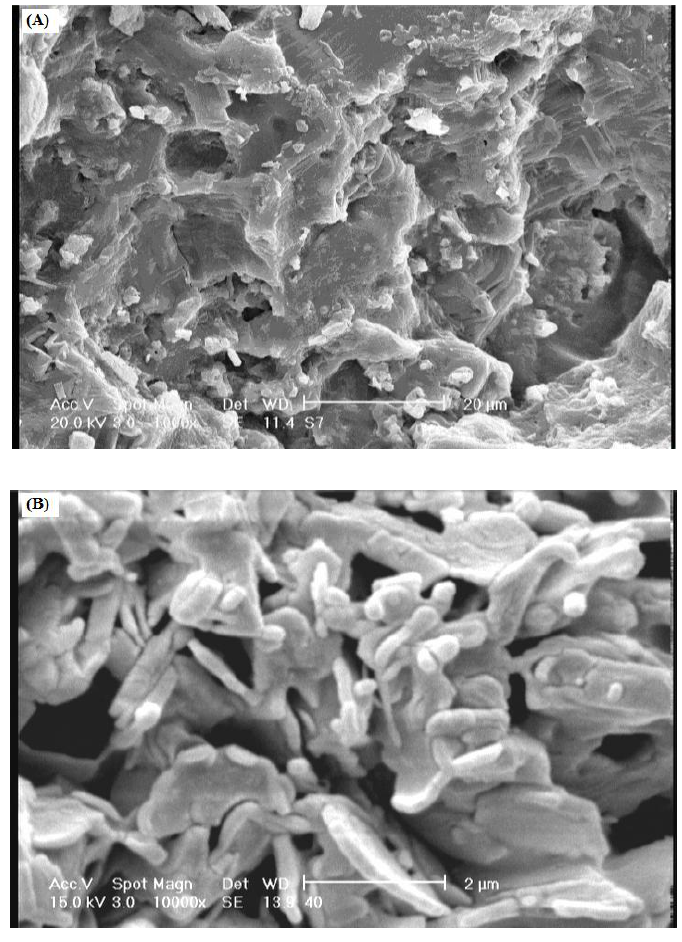
Figure 4. SEM photograph of the optimized hydrogel (gelatin 1.5 g, MBA 0.043 mol/L, APS 0.02 mol/L, 55 °C, 60 min). (A) Surface of porous hydrogel; (B) Cross-sectional area of porous